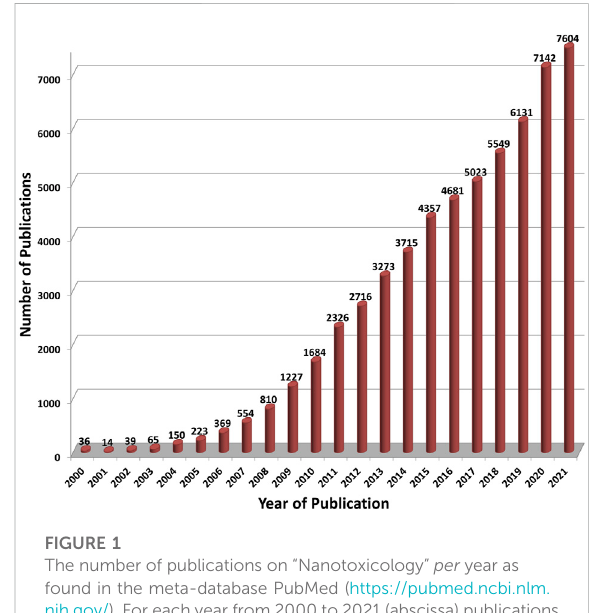
FIGURE 1 The number of publications on “ Nanotoxicology ” per year as found in the meta-database PubMed (https://pubmed.ncbi.nlm. nih.gov/). For each year from 2000 to 2021 (abscissa) publications have been searched within this database with the following search pro fi le: “ all fi elds ” contain “ nanotox* ” or “ fulleren* AND toxic* ” or “ nanotube AND toxic* ” or “ nanoparticle* AND toxic* ” or “ nanomat* AND toxic* or “ nano* AND toxic* ” or “ graphene AND toxic ” where the asterisk is a wild